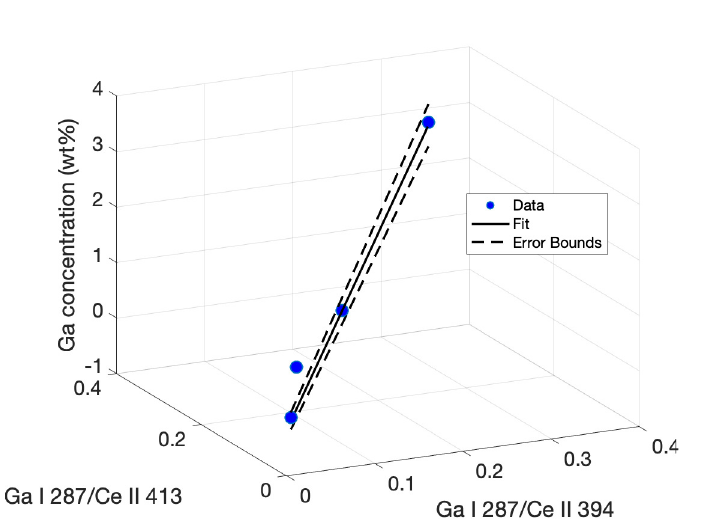
Figure 7. Multiple regression plot fitting ratios of the Ga I 287.4-nm peak intensity to a model determining Ga concentration based on the correlation between peak intensity